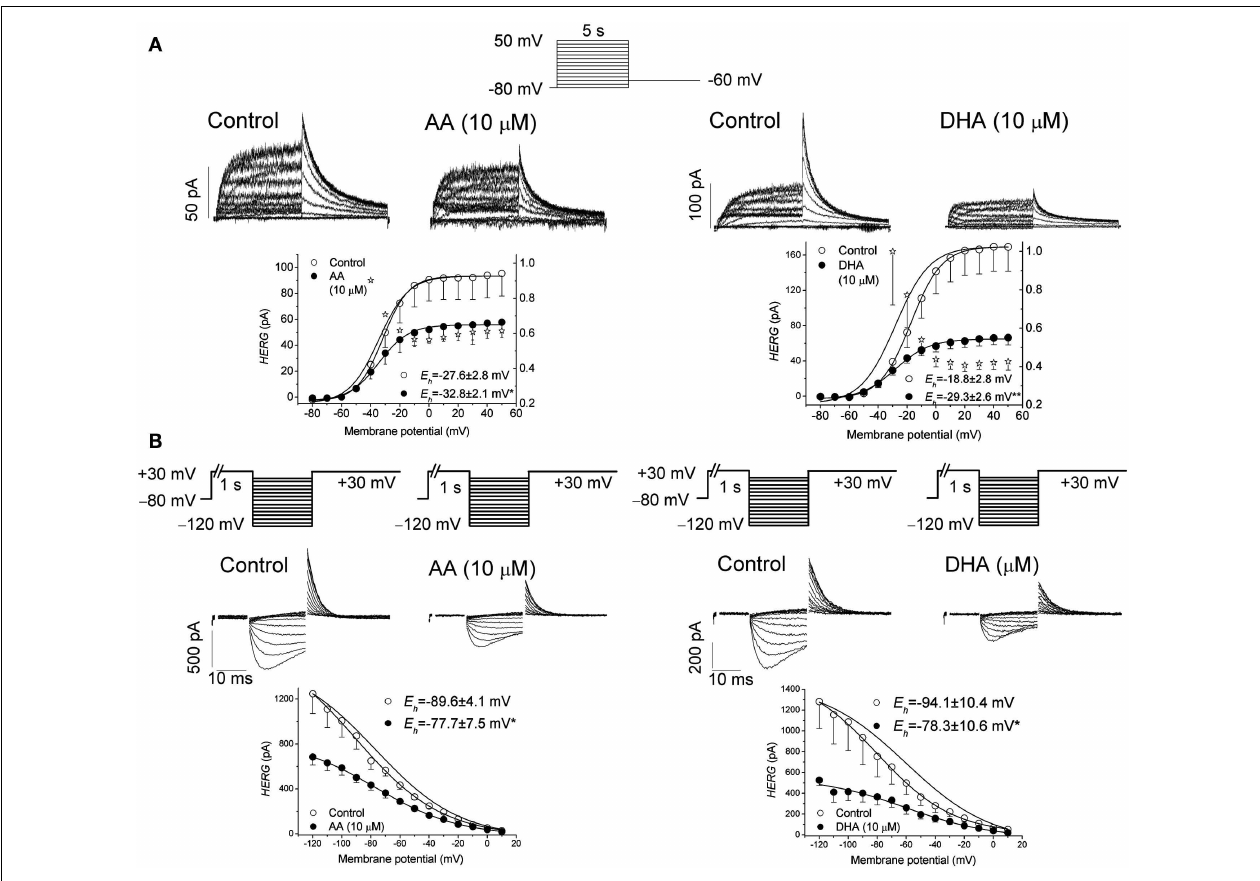
dependence of channel availability.The pulse protocol used to obtain each data point is shown at the top. Original traces obtained after applying such a pulse protocol in the absence and in the presence of 10 µ M AA and DHA. Corrected data for the deactivation together with the Boltzmann fit.The data were obtained from Guizy et al.